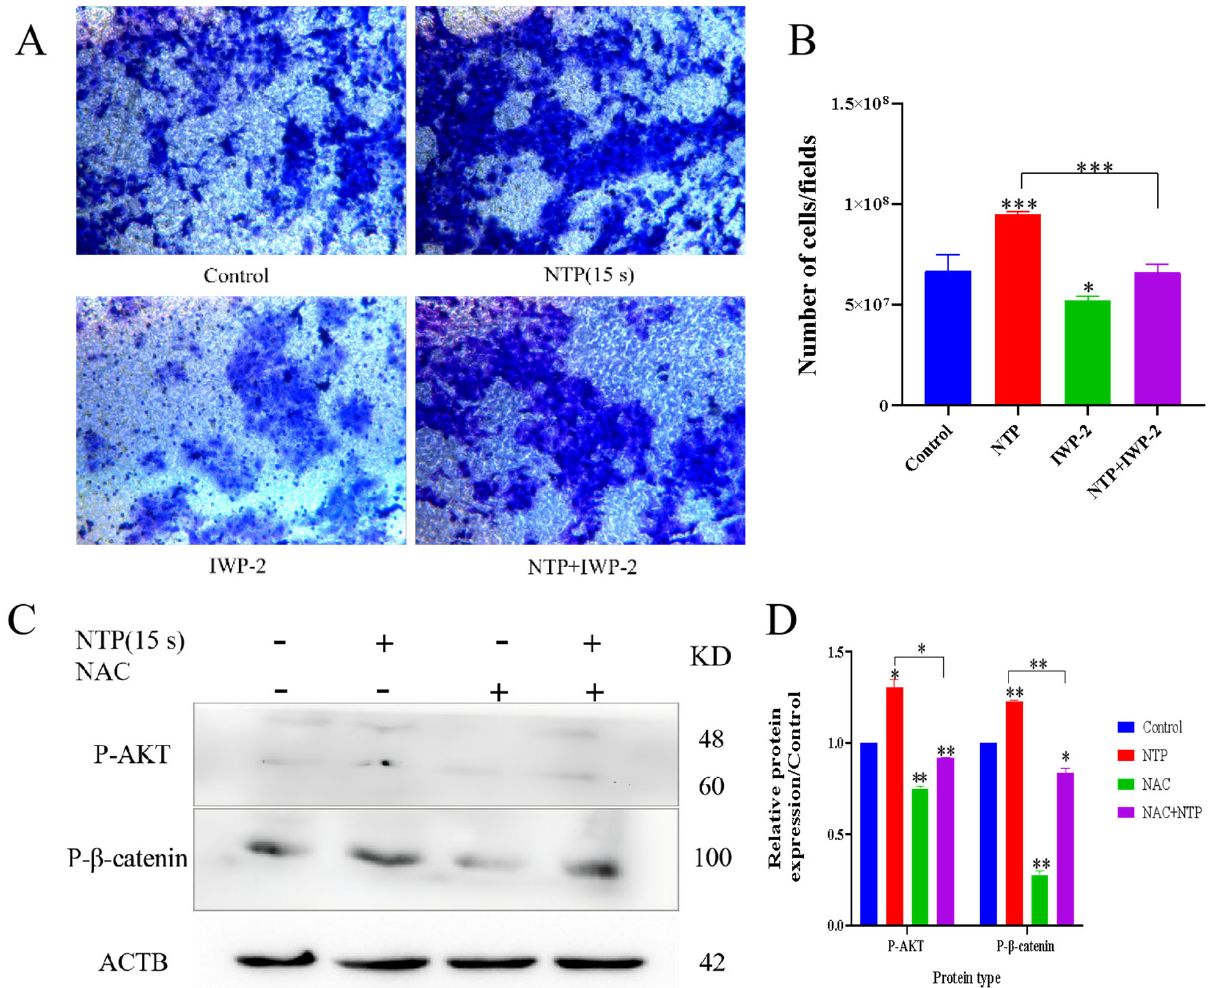
Figure 9. Effect of Wnt/ β -catenin pathway inhibitor IWP-2 on HaCaT cell migration and effect of NAC on protein phosphorylation. ( A ) Picture of effects of IWP-2, a Wnt/ β -catenin pathway inhibitor, on HaCaT cell migration. ( B ) Count of the number of migrated cells. ( C ) Effect of NAC on protein phosphorylation. ( D ) Quantification of phosphorylated protein expression. Data represent the mean ± SD of three independent experiments. * p < 0.05, ** p < 0.01, *** p < 0.001 with ANOVA compared with the control.